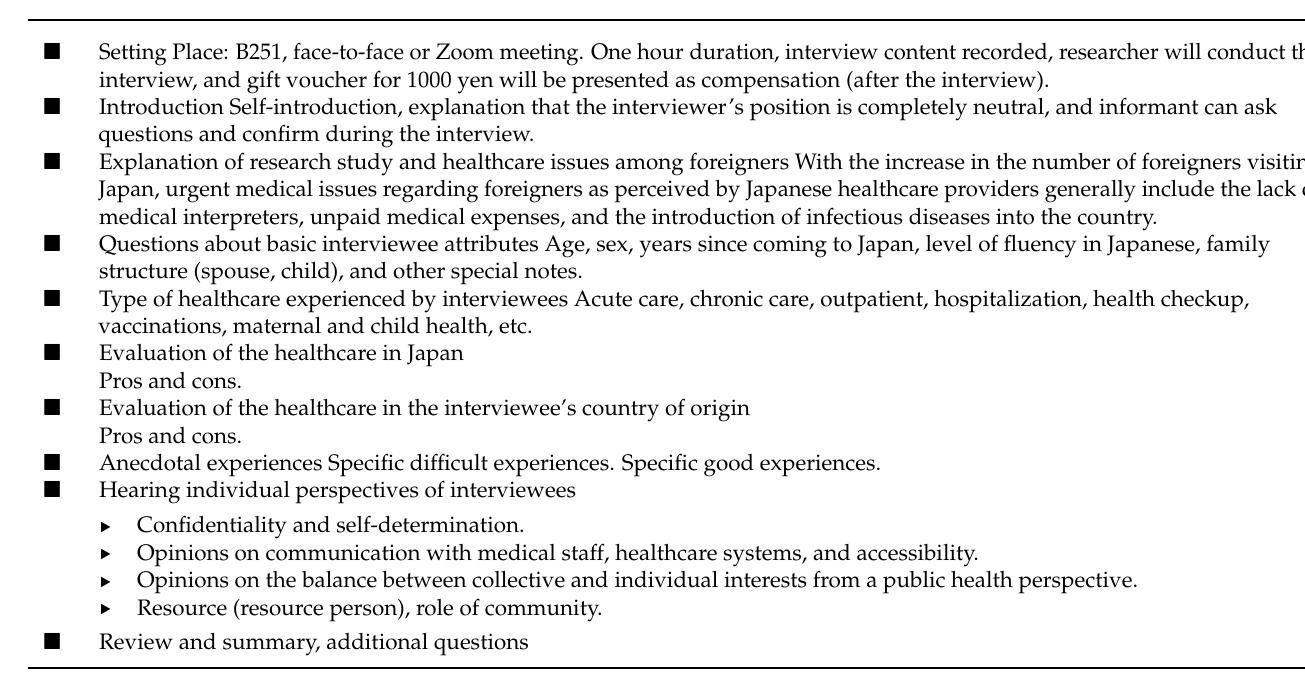
Table 2. Interview guide for the semi-structured interview to examine healthcare issues for foreign